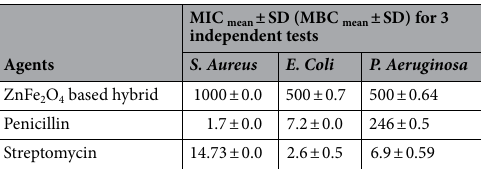
Table 1. MICs in µg/ml of synthesized hybrid against Gram-positive and Gram-negative bacteria and C. Albicans .